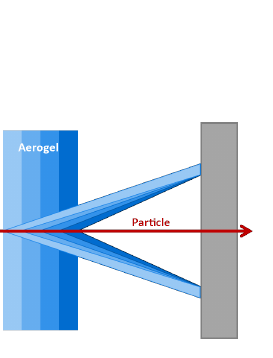
Figure 1. The Focusing Aerogel RICH con- cept.